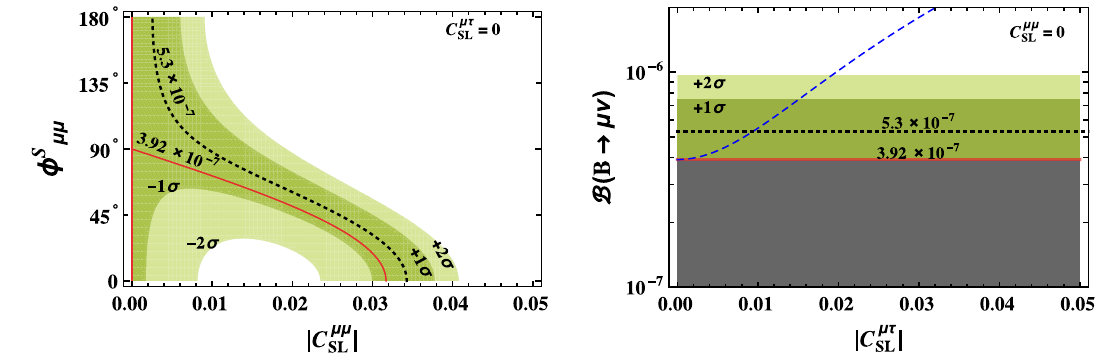
| = 0 mechanism respectively, while the current 1 σ and 2 σ ranges are shown in dark and SL light green shades. The B → μν rate can only be enhanced by | C | vs φ S μμ plane, SL μτ where a ¯ ν τ is emitted, which is marked by the darker gray shades below | dependenceof SL the SM (red) line in the right